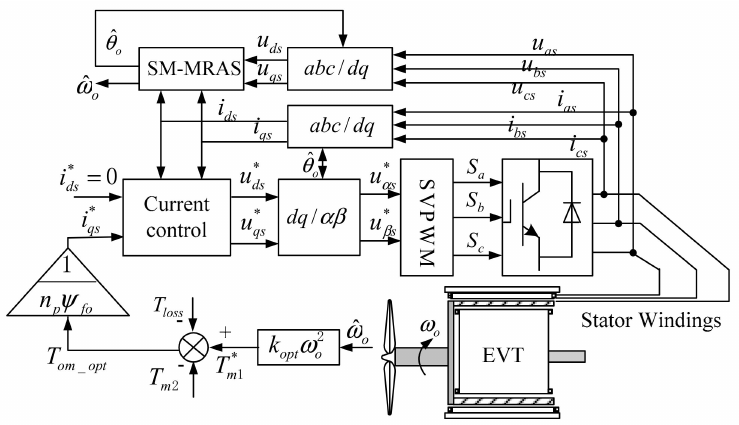
Figure 5. Control configuration of the outer rotor of the